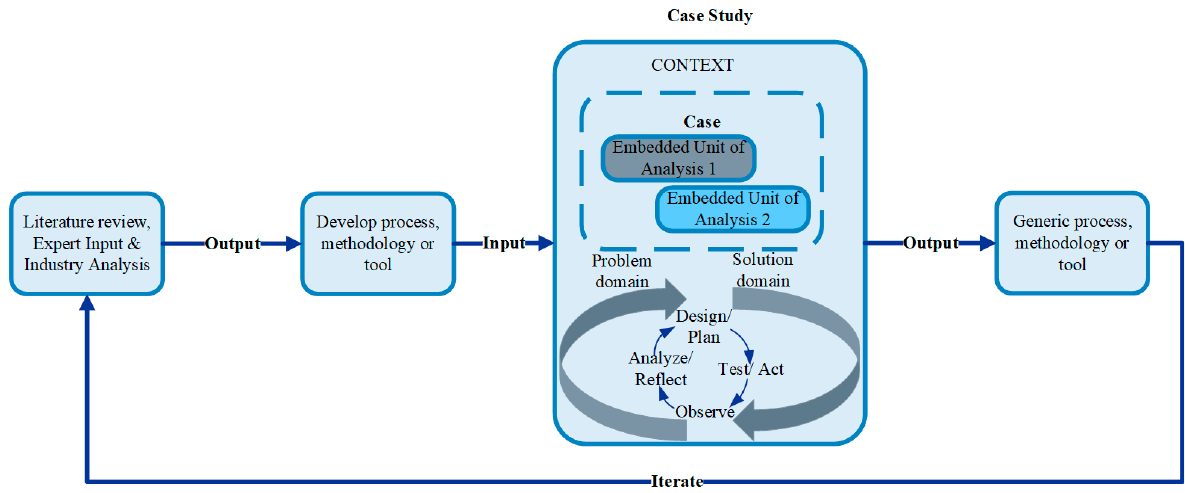
Figure 3. Research methodology for a case study with an embedded unit of analysis.